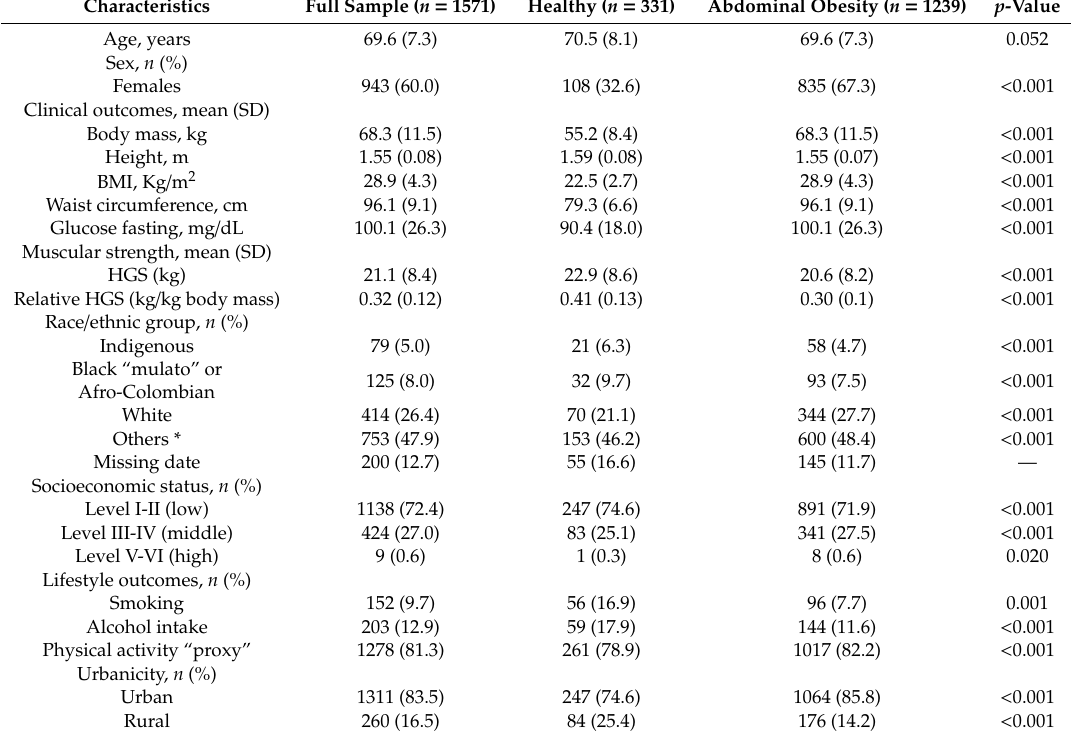
Table 1. Characteristics of the study participants ( n =